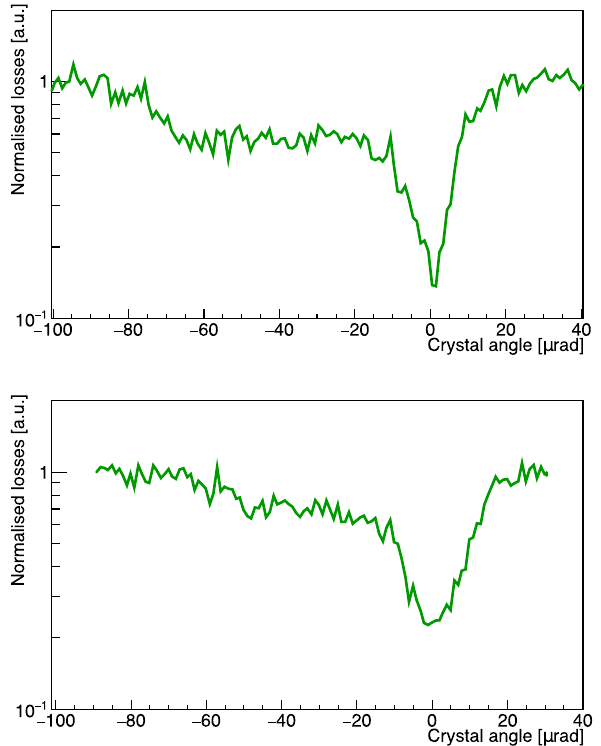
Fig. 4 Local beam losses normalized to the beam flux, and to the BLM signal in amorphous-like orientations, as a function of the crystal angle forthehorizontalstrip(top)andverticalquasi-mosaic(bottom)crystals. Scans were performed at 450Z GeV